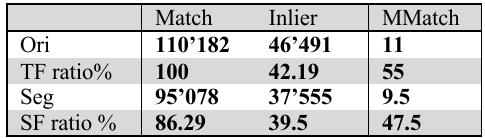
Table 5 . Matching result of the Segmented (Seg) case and Original (Ori). Match, total number of matches possible. Inlier, based on Homography matrix estimation (incl. Ransac). MMatch, number of miss matches based on 20 random selected matches. TF ratio and SF ratio are based on AVG of TF (total amount of features) and SF (number of features after